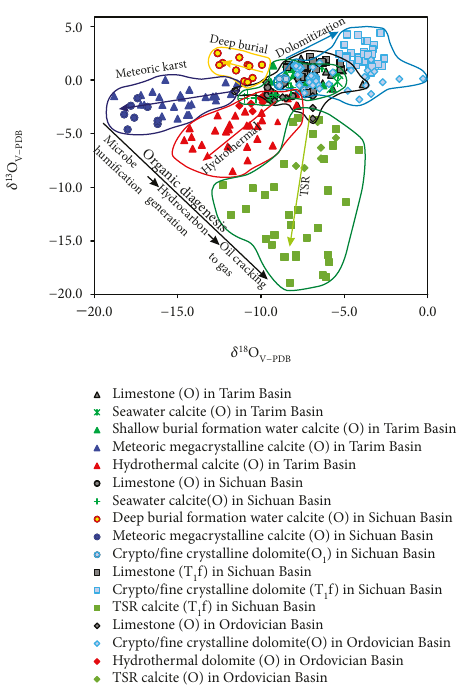
Figure 4: Carbon and oxygen isotope compositions to identify di ff erent fl uid alterations in the deep marine carbonate reservoirs.